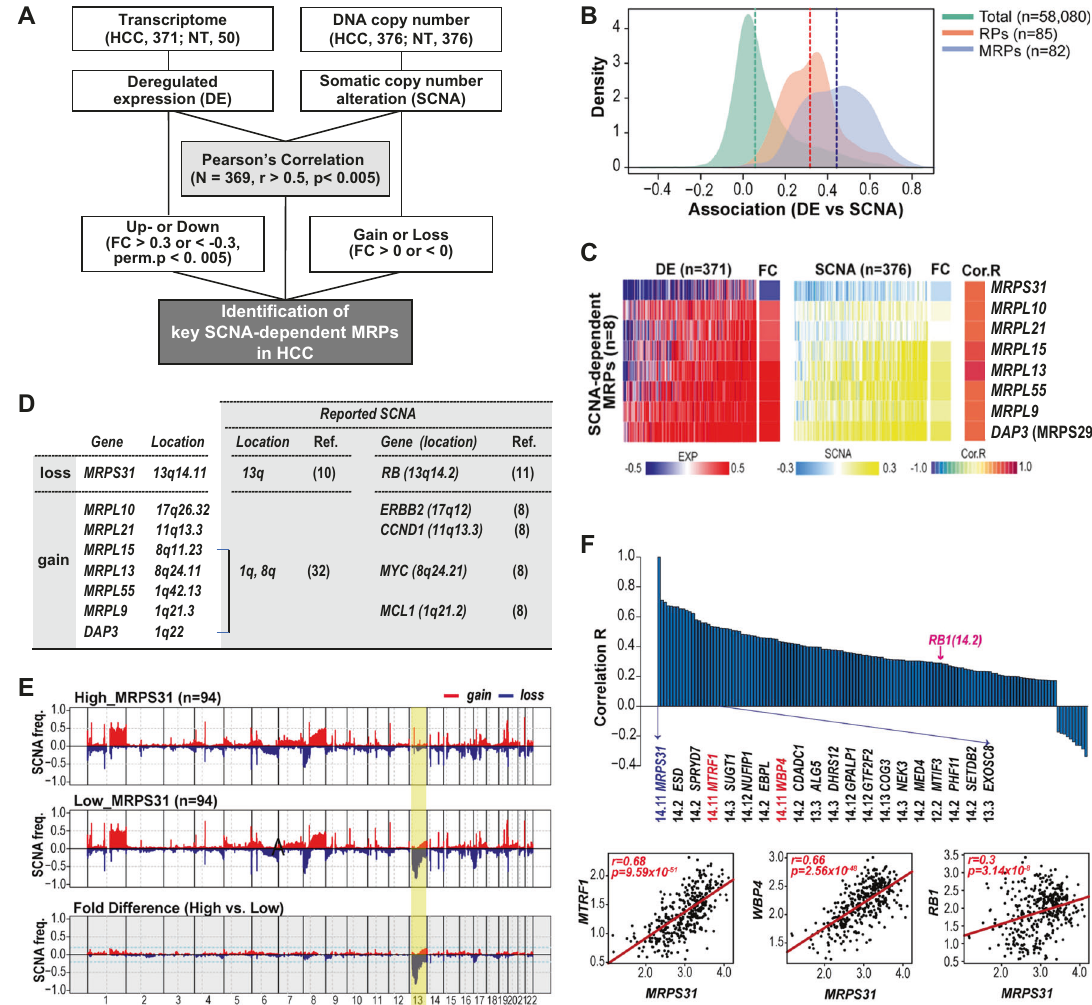
Fig. 1 Identi fi cation of key SCNA-dependent MRPs in HCC. A Schematic fl ow of the analysis to identify key SCNA-dependent MRPs. B Histograms of the association between DE and SCNA of total genes, RPs, and MRPs. C Heatmaps of DE (left), SCNA (middle), and Cor. R (right) of eight SCNA-dependent MRPs. Average fold changes (FC) of the HCC samples ’ DE and SCNA values are included. D Commonly reported SCNA-associated locations and genes and their link to the MRPs. E Whole chromosome SCNA frequencies of high and low MRPS31-DCN groups and their fold differences (bottom). Chromosome boundaries (perpendicular solid lines) and centromere positions (dashed) are indicated and chromosomal region with substantial frequency differences between the two groups was colored yellow. F Correlation estimates between expressions of MRPS31 and the genes located in the yellow-colored region of ( E ). The top 20 genes with high correlation are listed with their location. Scatter plots (lower panel) of the association between expressions of MRPS31 and neighboring genes (MTRF1 and WBP4) or RB1. The statistical r and p values by Pearson ’ s product-moment correlation test are